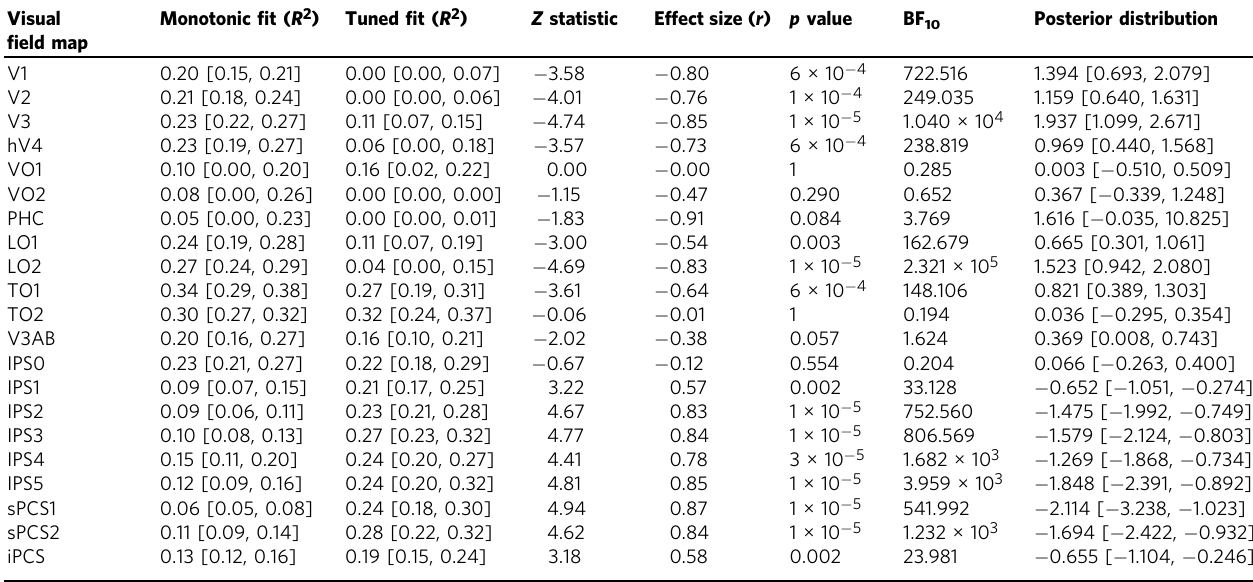
Table 1 Descriptive and test statistics of the paired model comparisons within visual fi eld maps. Visual fi eld